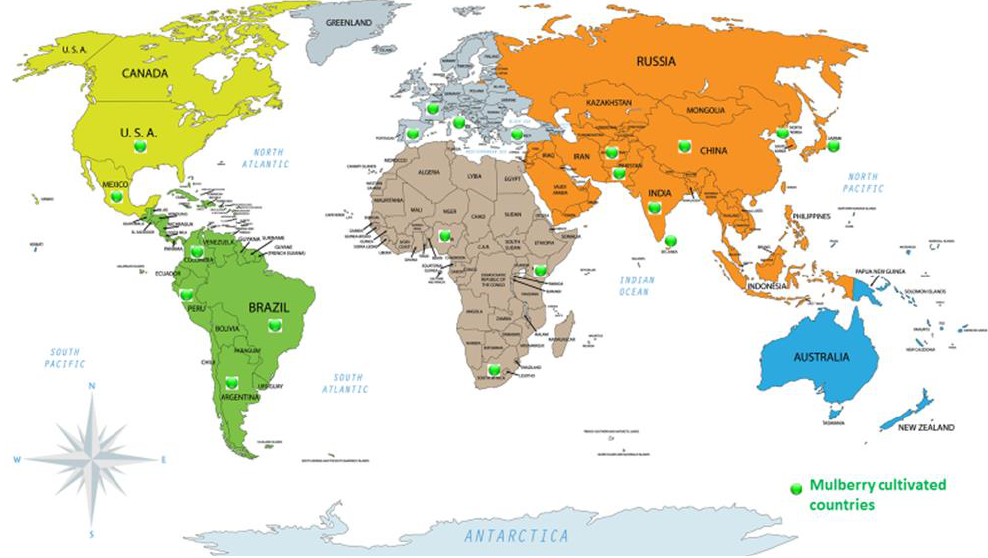
Figure 1. Worldwide distribution of mulberry cultivation.